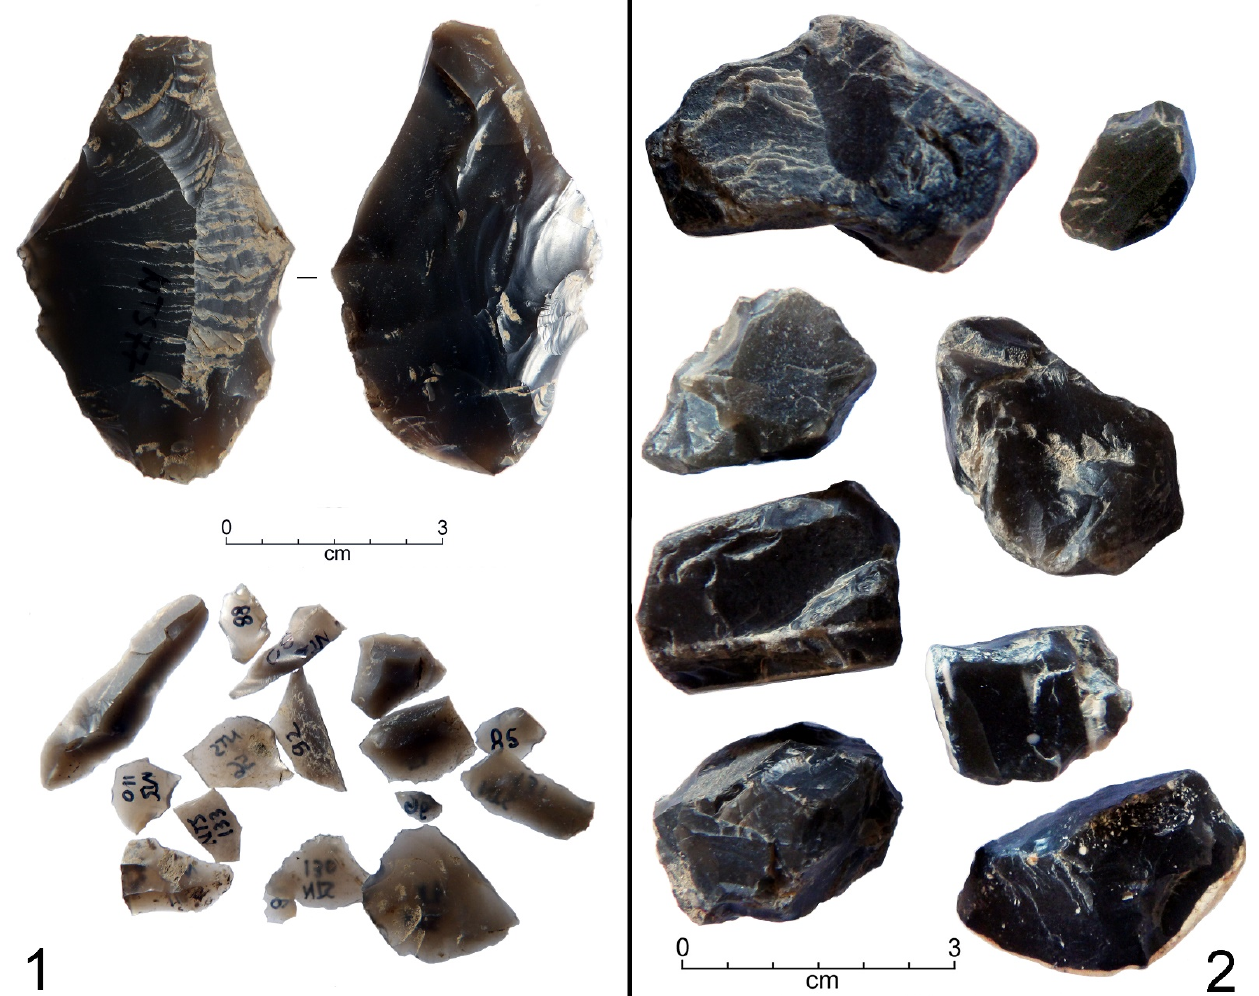
Figure 5. Mount Anitsa: bifacial rough-out (NTS-77) and debitage microflakelets of the same variety of non-local Vikos “black chert” (n. 1). The NTS lithic manufacturing spot has been radiocarbon dated to 5356 ± 26 BP (GrM-28122: NTS-25) by one Fraxinus charcoal fragment. Geological samples of Vikos “black chert” from the Vikos Gorge outcrops in Epirus (n. 2) (photographs by E. Starnini, 2022).